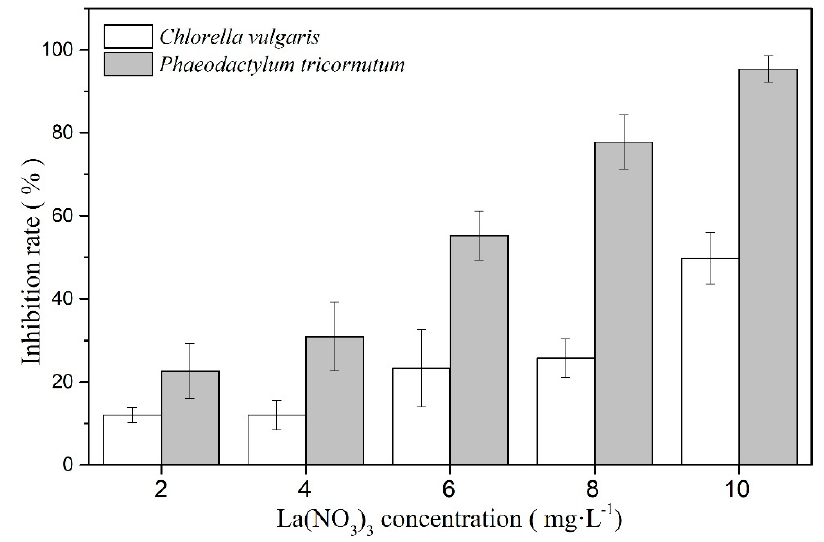
Figure 1. Inhibition rate for various concentrations of La(NO 3 ) 3 · 6H 2 O in 96 h.